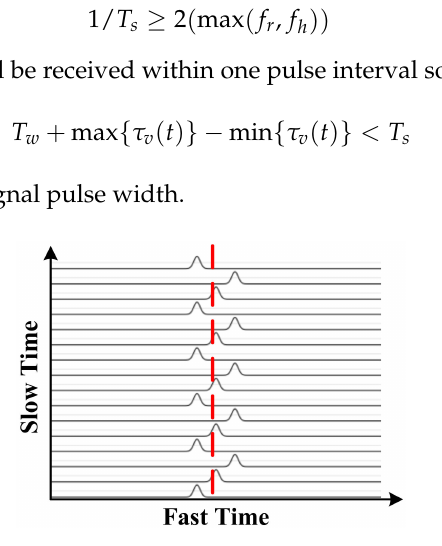
Figure 2. The ideal pulses acquired from one human subject.